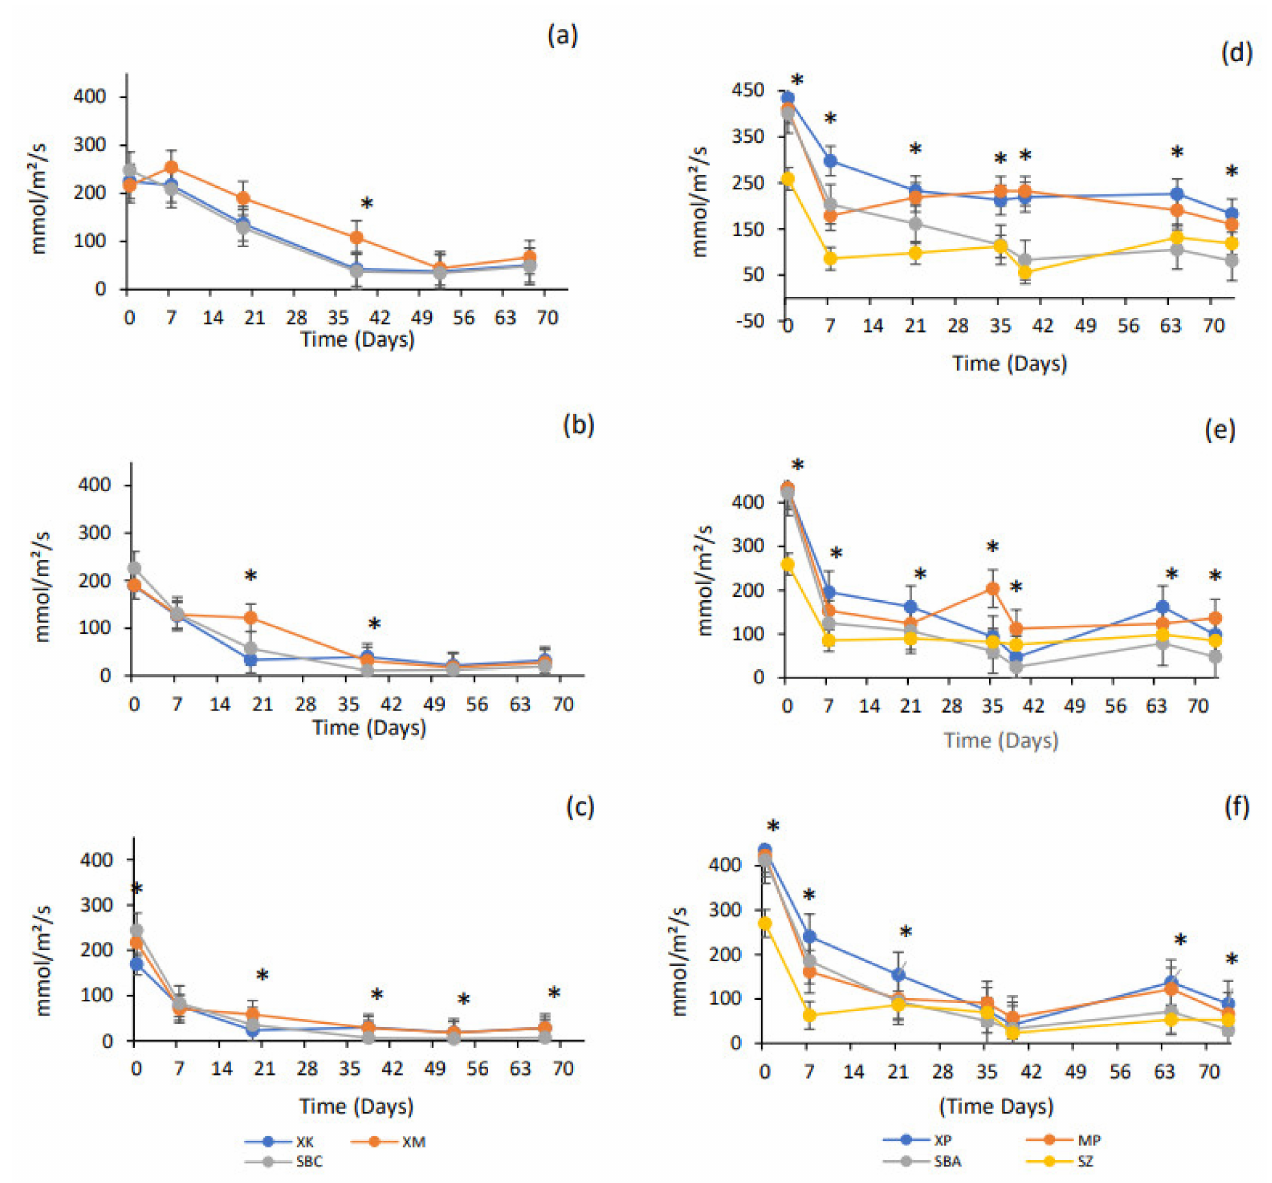
Figure 7. Stomatal Conductance (mmol/m 2 /s) measures for potted trial for seasons 2019 and 2020/2021. XM—Xynisteri Mandria, XK—Xynisteri Kathikas, XP—Xynisteri Paphos, MP—